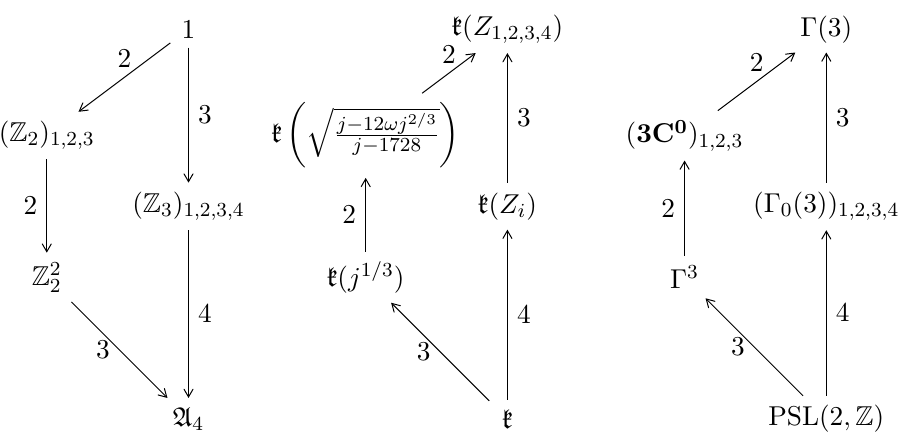
Figure 8 . Summary of the Galois correspondence for gauge algebra su (4). Here ! is a third root of